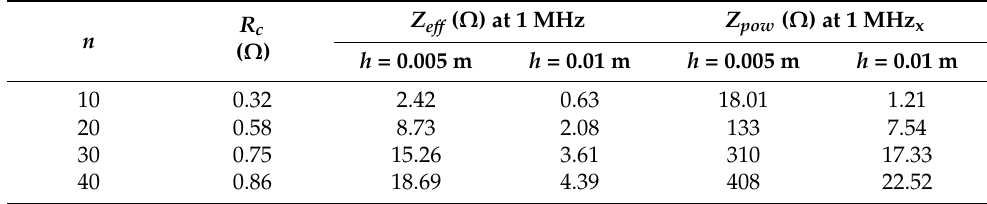
Table 2. Calculated circuit parameters for r = 0.01 m (without skin effect).